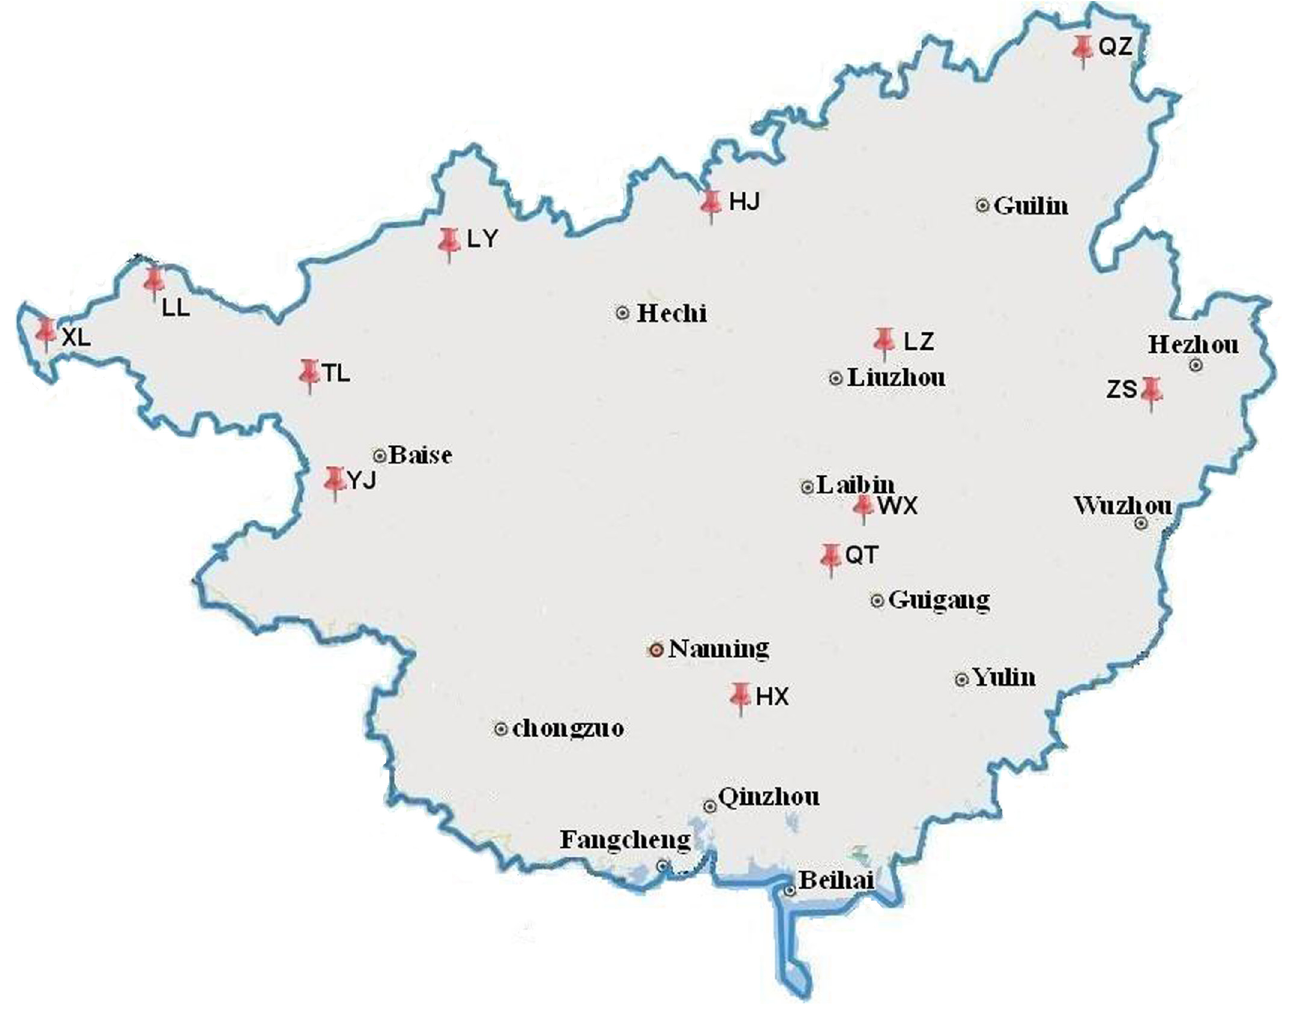
Fig 1. The localities of the natural D . kaki var . silvestris Mak samples.